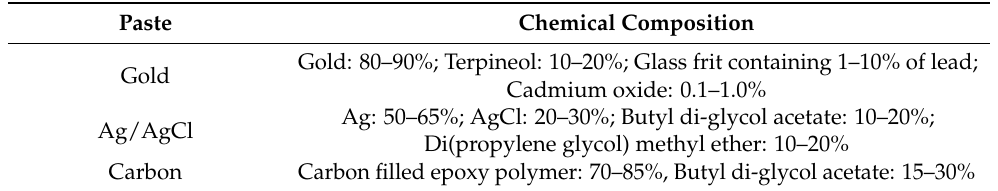
Table 1. Chemical composition of pastes used for electrodes (data from